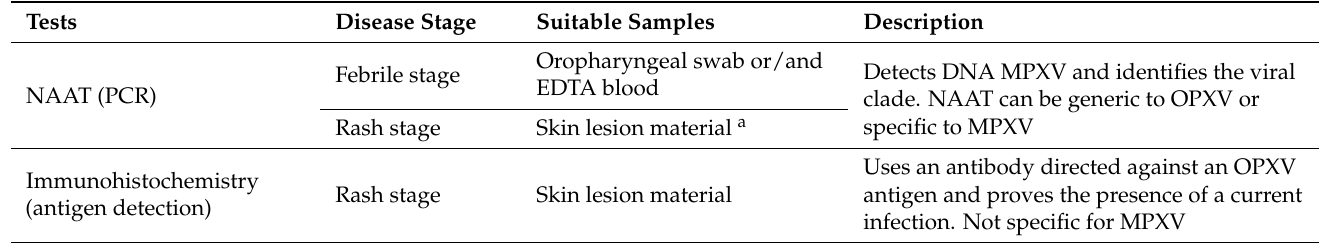
Table 5. Diagnostic tests overview for MPXV, including disease stage and suitable samples to be